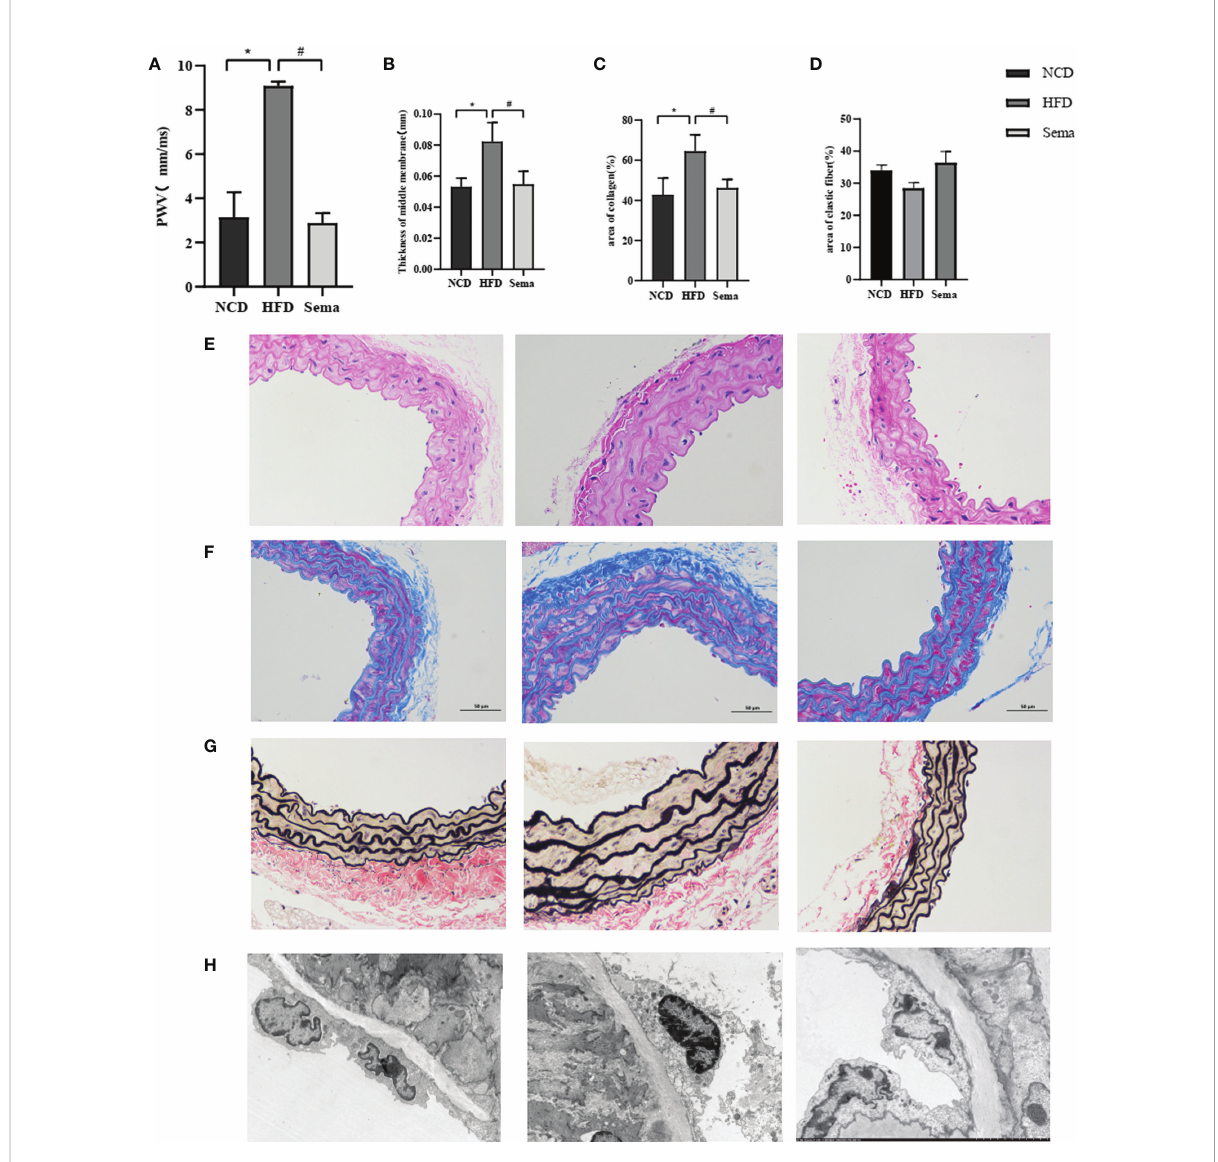
FIGURE 3 (A) PWV of aorta of three groups of mice. (B) The thickness of the blood vessel walls of aorta of three groups of mice. (C) Collagen levels of aorta of three groups of mice. (D) elastin fi bers of aorta of three groups of mice. (E) The thickness of the blood vessel walls of aorta of three groups of mice in HE. (F) The thickness of the blood vessel walls of aorta of three groups of mice in masson staining. (G) Collagen levels of aorta of three groups of mice in EVG staining. (H) elastin fi bers of aorta of three groups of mice in TEM. Results are expressed as mean ± SD the standard error of the mean. (n=3). * means NCD vs HFD; # means HFD vs